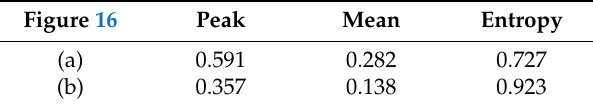
Table 9. Results of MPSM jamming in Figure 16.